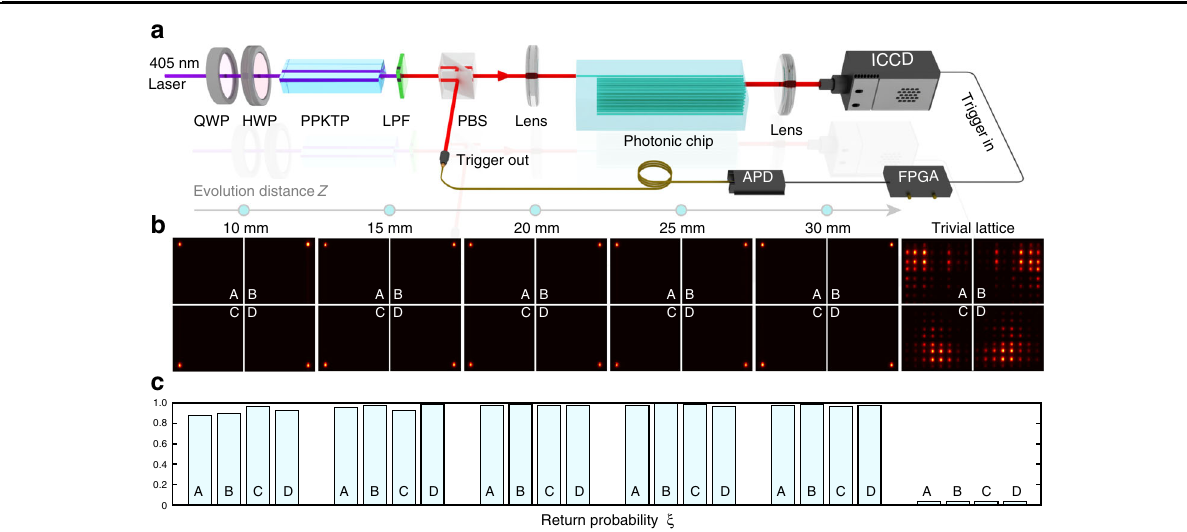
Fig. 2 The experimental setup and measured distribution probability. a Schematic of the experimental setup. The heralded single photons generated from the PPKTP crystal are injected into the lattices after being focused and then collimated by a lens, and collected at the output facet by an ICCD, meanwhile, the heralding photon acts as the trigger. HWP: half-wave plate, QWP: quarter-wave plate, LPF: long-pass fi lter, APD: avalanche photodiode. b , c The measured distribution probability and localization index of the corner states. The parameters of C 4 symmetric lattice